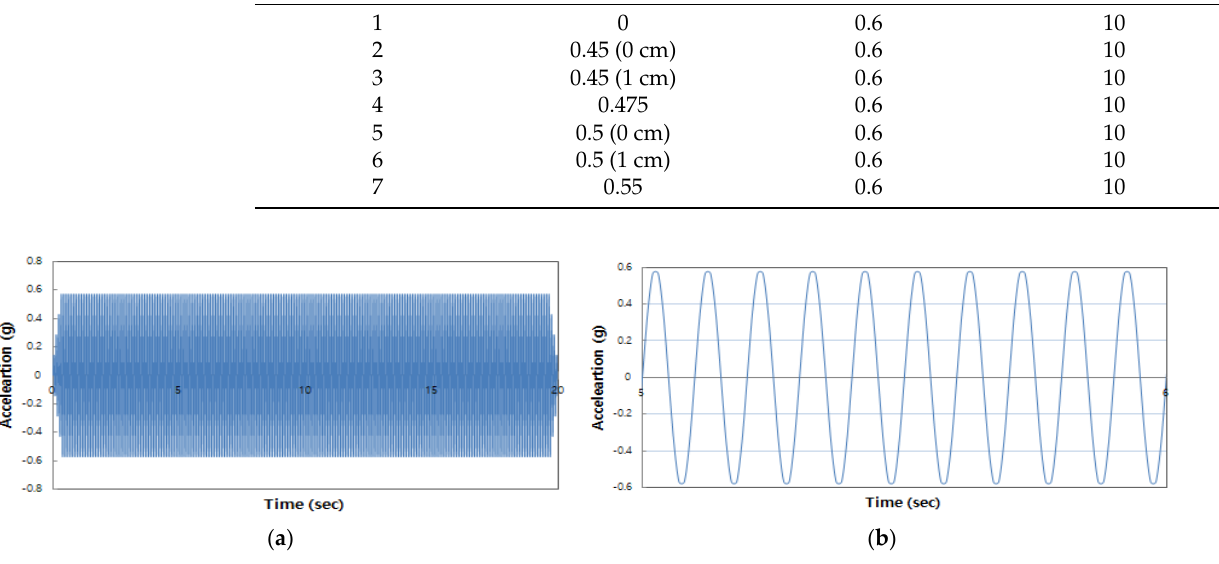
Figure 4. Input motion at 0.6 g and 10 Hz: ( a ) Whole shaking; ( b ) Shaking wave between 5 and 6 s. Table 2. Characteristics of experiments.